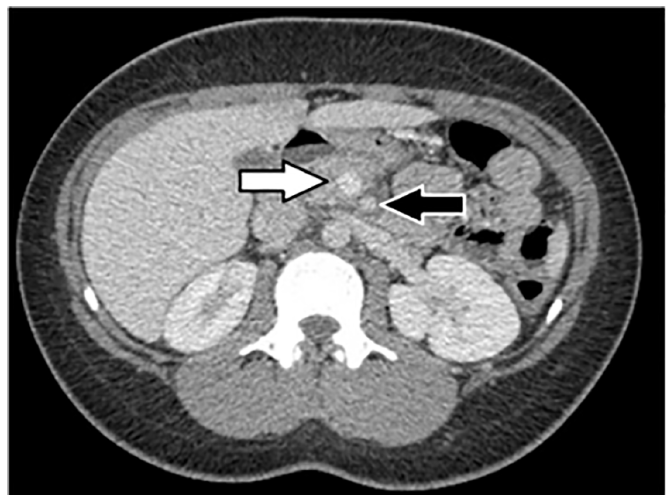
Image 2. This axial computed tomography image shows the normal appearance of the superior mesenteric artery (black arrow) and just adjacent to it, the superior mesenteric vein (white